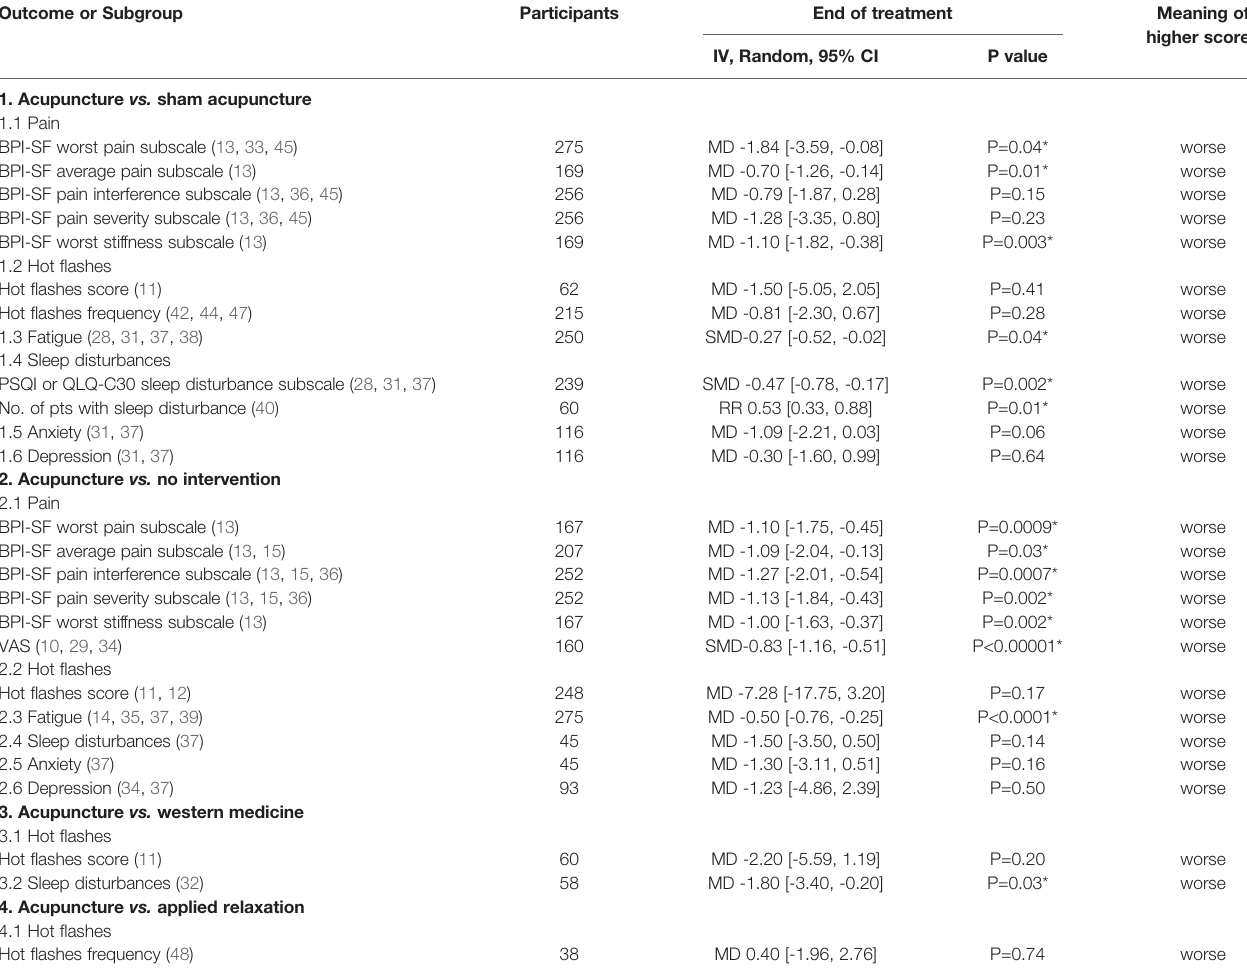
TABLE 3 | The effect of acupuncture on the secondary outcomes compared to different comparators. Outcome or